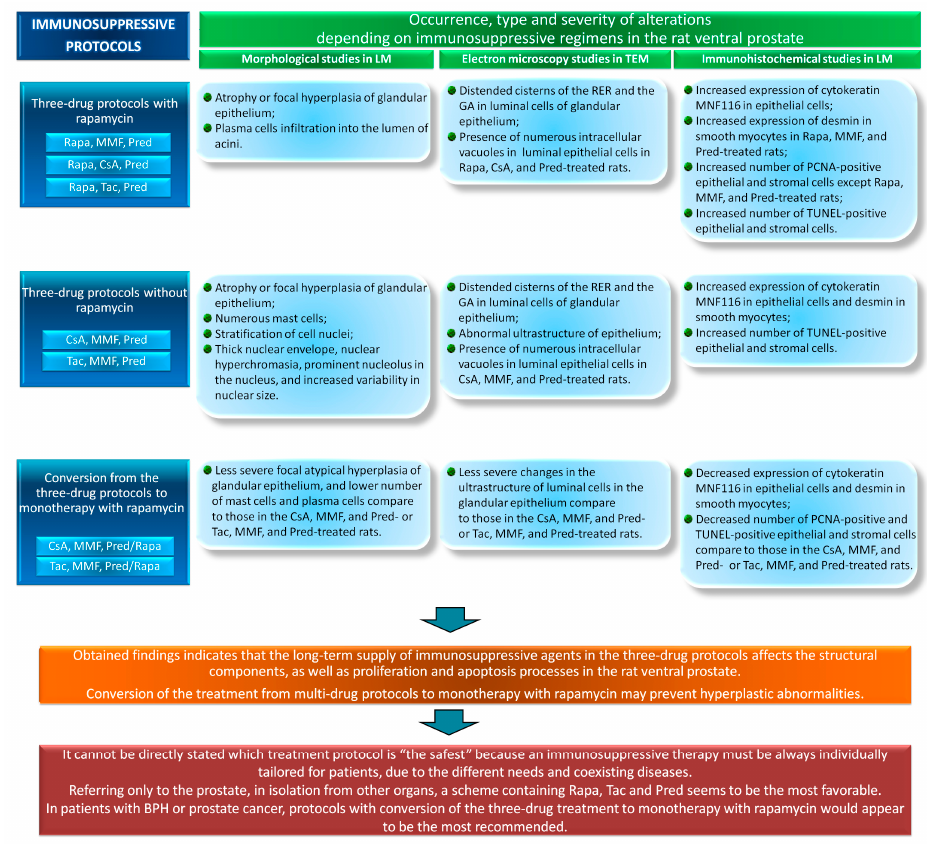
Figure 7. The effects of immunosuppressive regimens on the rat ventral prostate based on current and previous [10] studies (details in the text). BPH: benign prostate hyperplasia; CsA: cyclosporin A; GA: Golgi apparatus; LM: light microscopy; MMF: mycophenolate mofetil; PCNA: proliferating cell nuclear antigen; Pred: prednisone; Rapa: rapamycin; RER: rough endoplasmic reticulum; Tac: tacrolimus; TEM: transmission electron microscopy; TUNEL: terminal deoxynucleotidyl transferase-mediated dUTP nick-end labeling.